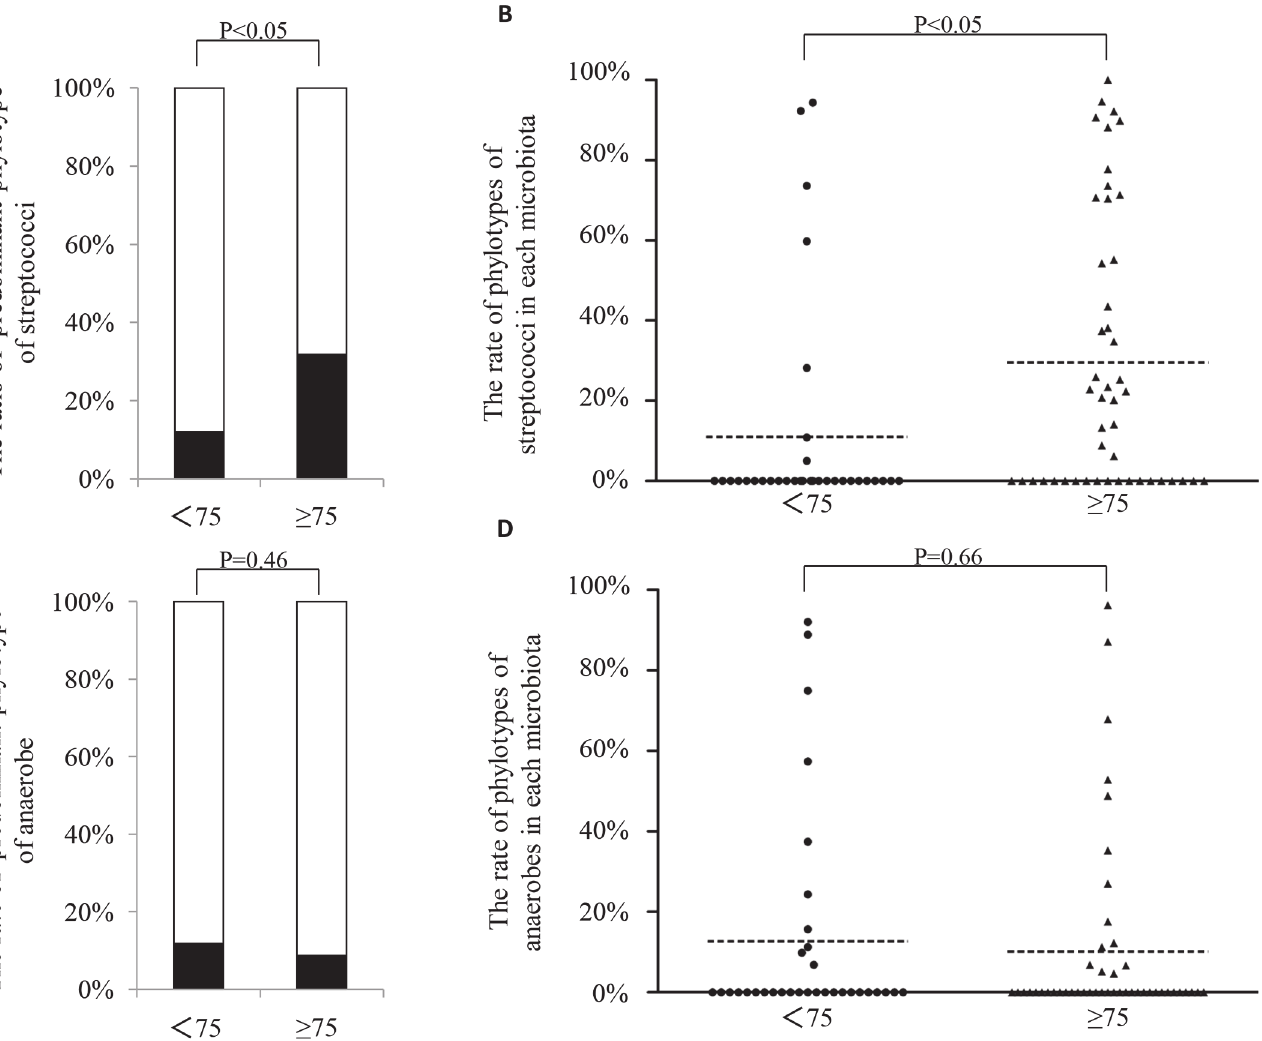
Fig 2. Comparison of the predominat phylotype and the rates of phylotypes of streptococci or anaerobes. A) With respect to streptococci, the rate of a predominant phylotype was significantly higher in the patients equal to or older than 75 years of age (the rates of streptococci in the patients younger than 75 years old and equal to or older than 75 years of age were 12.1% and 31.9%, respectively; P < 0.05); B) The rates of the phylotypes in each microbiota were significantly higher in the patients equal to or older than 75 years of age ( < 75 vs (cid:1) 75 were 11.0 ± 27.0% and 29.5 ± 34.1%, respectively; P < 0.05); C-D) Regarding anaerobes, the rate of the predominant phylotype ( < 75 vs (cid:1) 75 were 11.8% vs 8.7%, respectively; P = 0.46) and the phylotypes in each microbiota ( < 75 vs (cid:1) 75 were 12.7 ± 26.5% vs 10.2 ± 23.1%, respectively; P = 0.66) were not significantly different between the two age